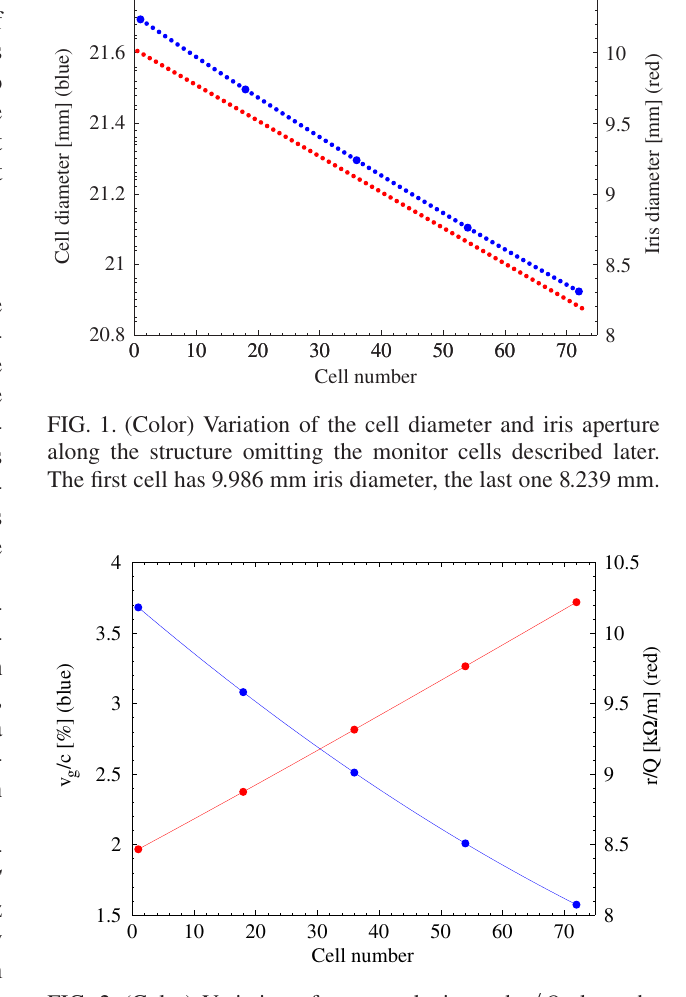
FIG. 2. (Color) Variation of group velocity and r=Q along the